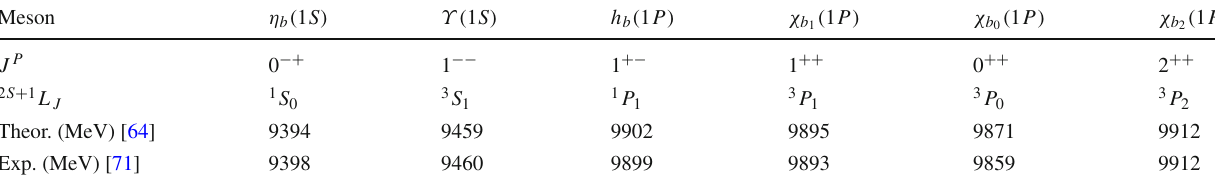
Table 3 Masses of the low-lying S - and P -wave ¯ bb mesons calculated in Ref. [64]